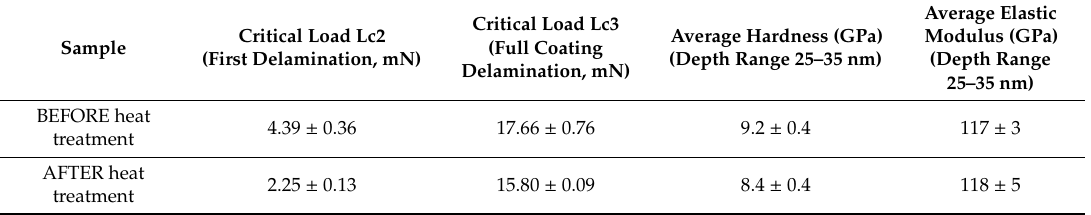
Table 1. Result summary on nanoindentation and nanoscratch